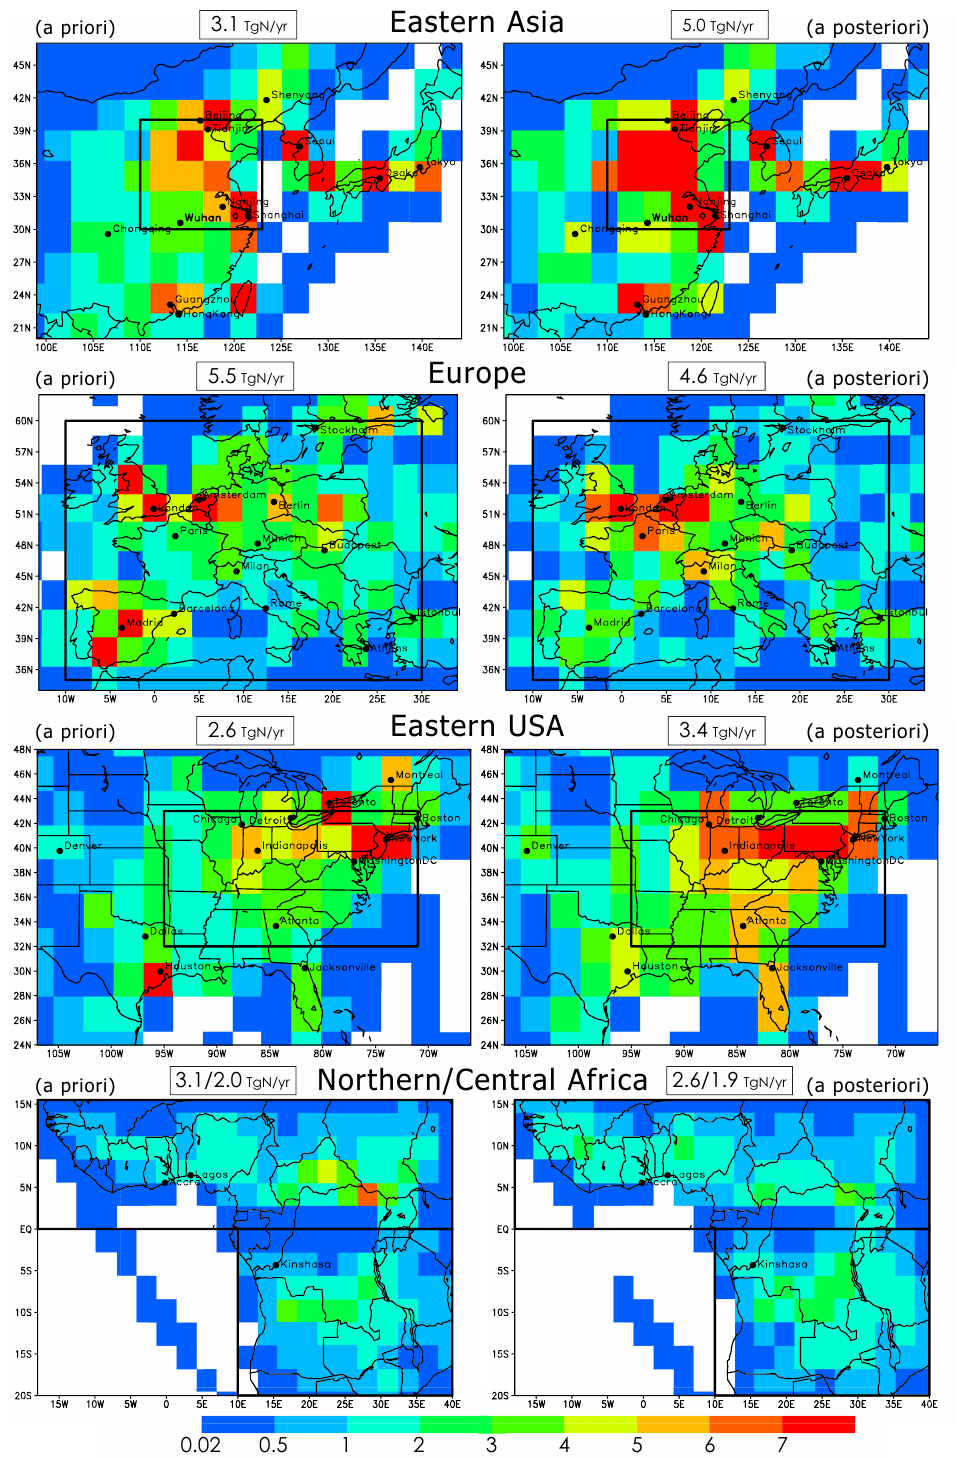
Fig. 8. Same as Fig. 6, but showing the regional distribution over eastern Asia (upper panels), Europe (upper middle panels), the eastern United States (lower middle panels), and central Africa (lower panels), obtained from the a priori emissions (left panels) and the a posteriori emissions (right panels), averaged over four months, January, April, July, and October, in 2005. The black square line represents the region used for the regional mean analysis; the number shown in the top of the panels represents the total NO x emission for the regional domain. The red (blue) colour indicates relatively high (low)